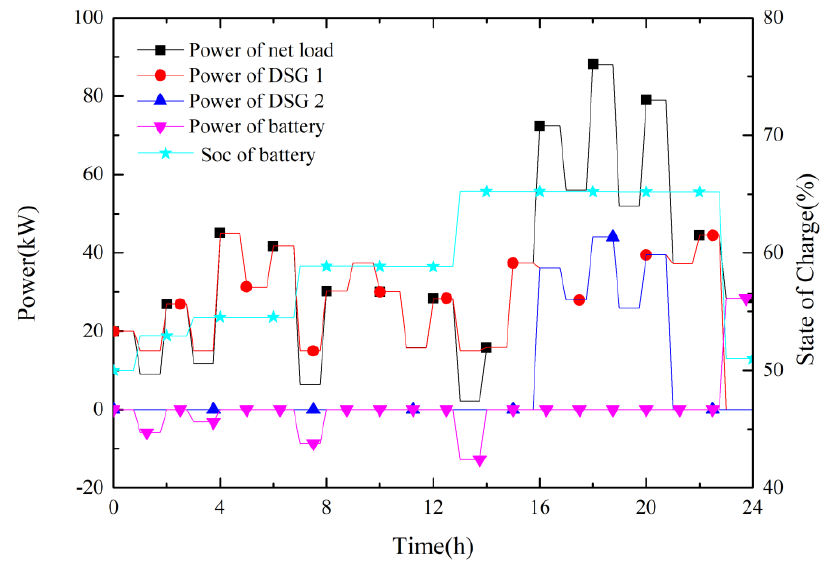
Figure 5. Day-ahead schedule of each type of DG.